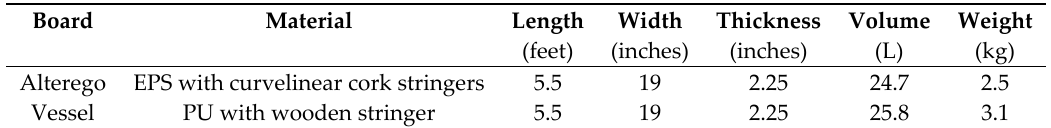
Table 1. Boards generic